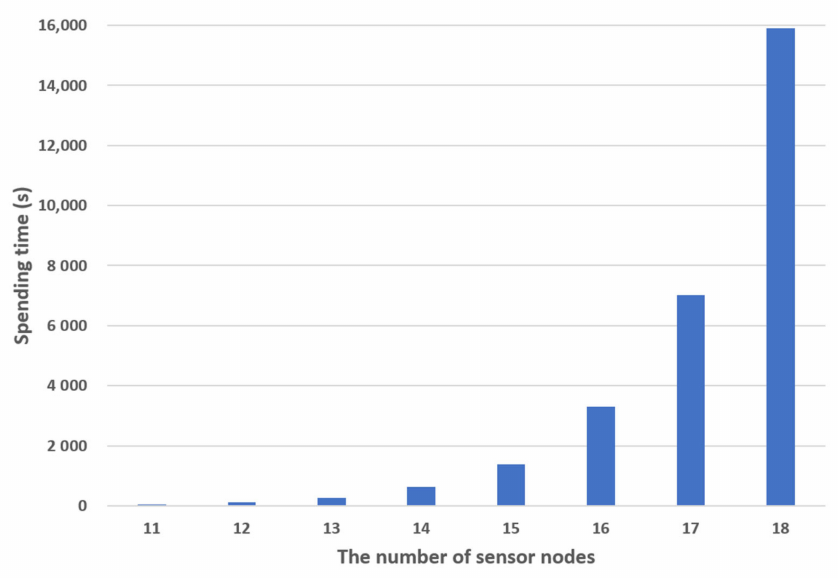
Figure 5. Average spending time to check all cases.